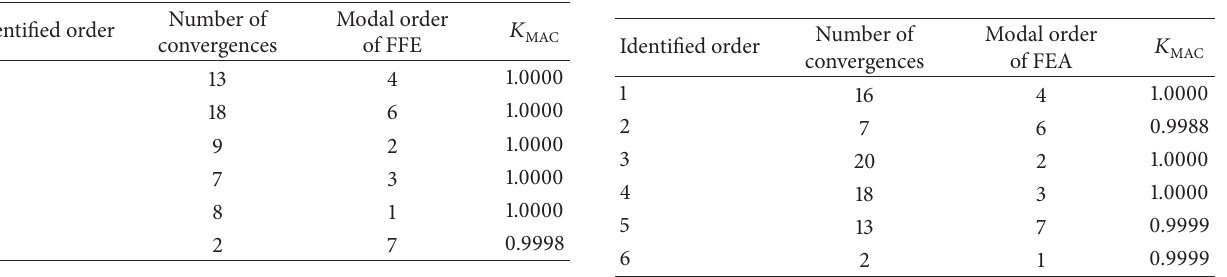
Table 4: The convergence times and MAC value of modal shapes.